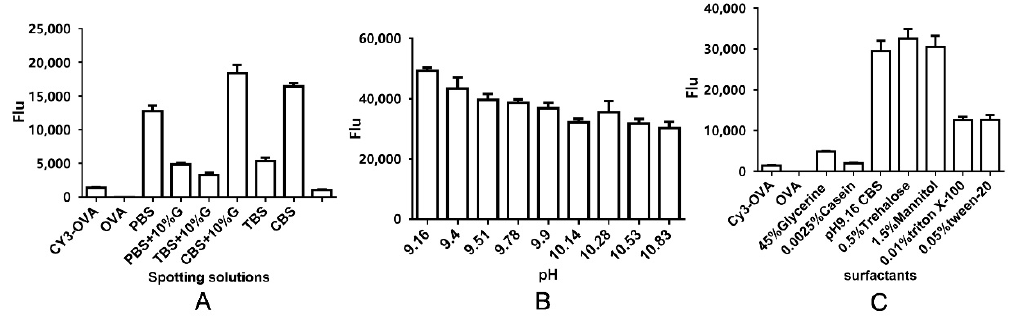
Figure 5. The effect of spotting solutions on